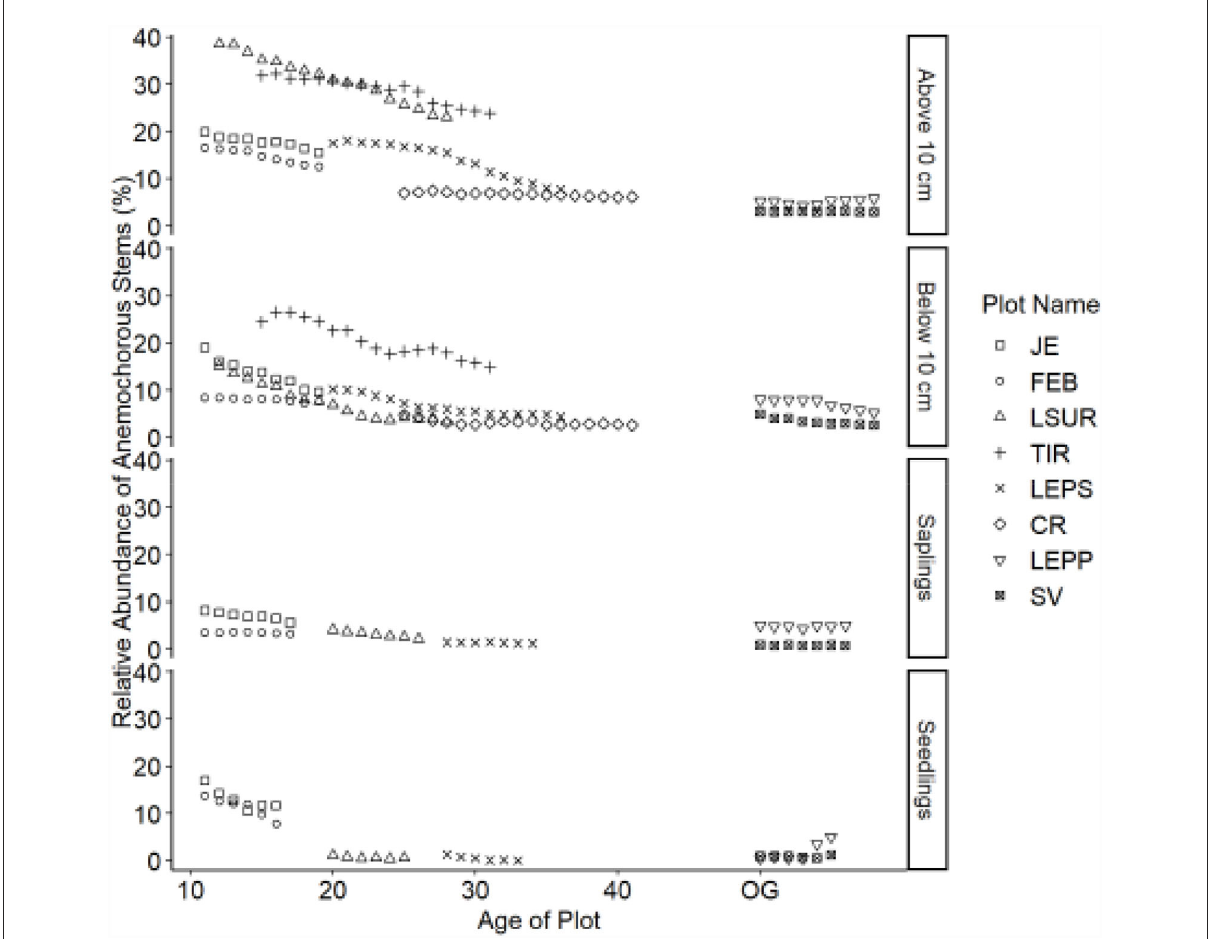
FIGURE3 Relative abundance of anemochorous stems. Table 1 indicates the plot acronyms, which appear from youngest to oldest, top to bottom in the legend.